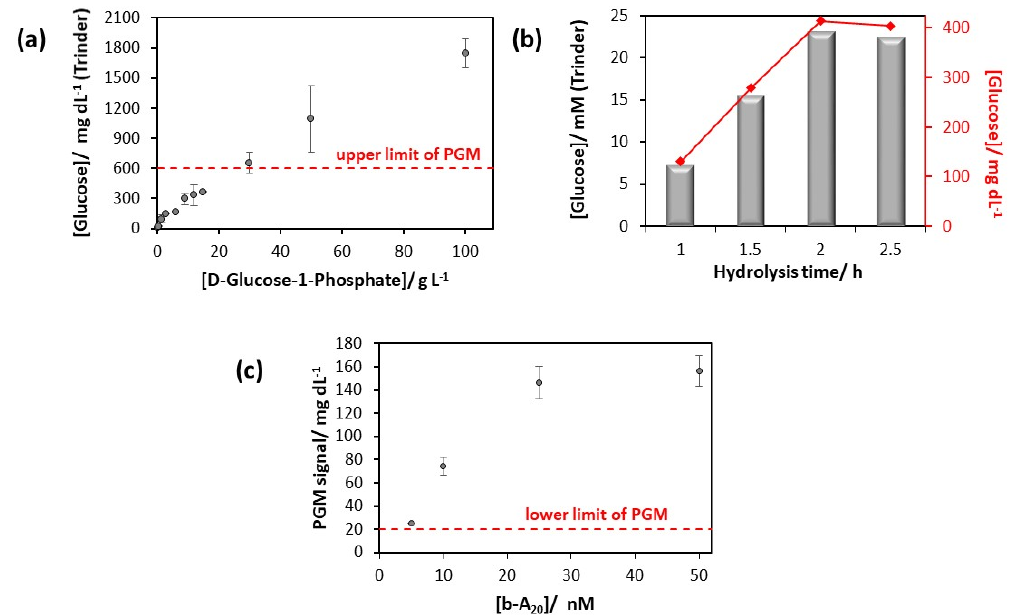
Figure 3. Studies of b-A 20 detection by using ALP for catalytic glucose generation. ( a ) E ff ect of D-glucose-1-phosphate concentration on the analytical signal obtained by Trinder method. ( b ) E ff ect of enzymatic hydrolysis time on the analytical signal obtained by Trinder method. ( c ) Detection of the model target b-A 20 using the PGM under the optimized